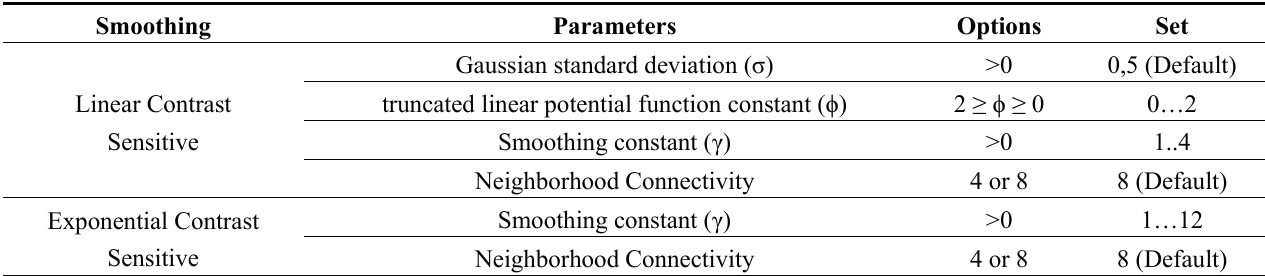
Table 6. Parameter settings of each classification with